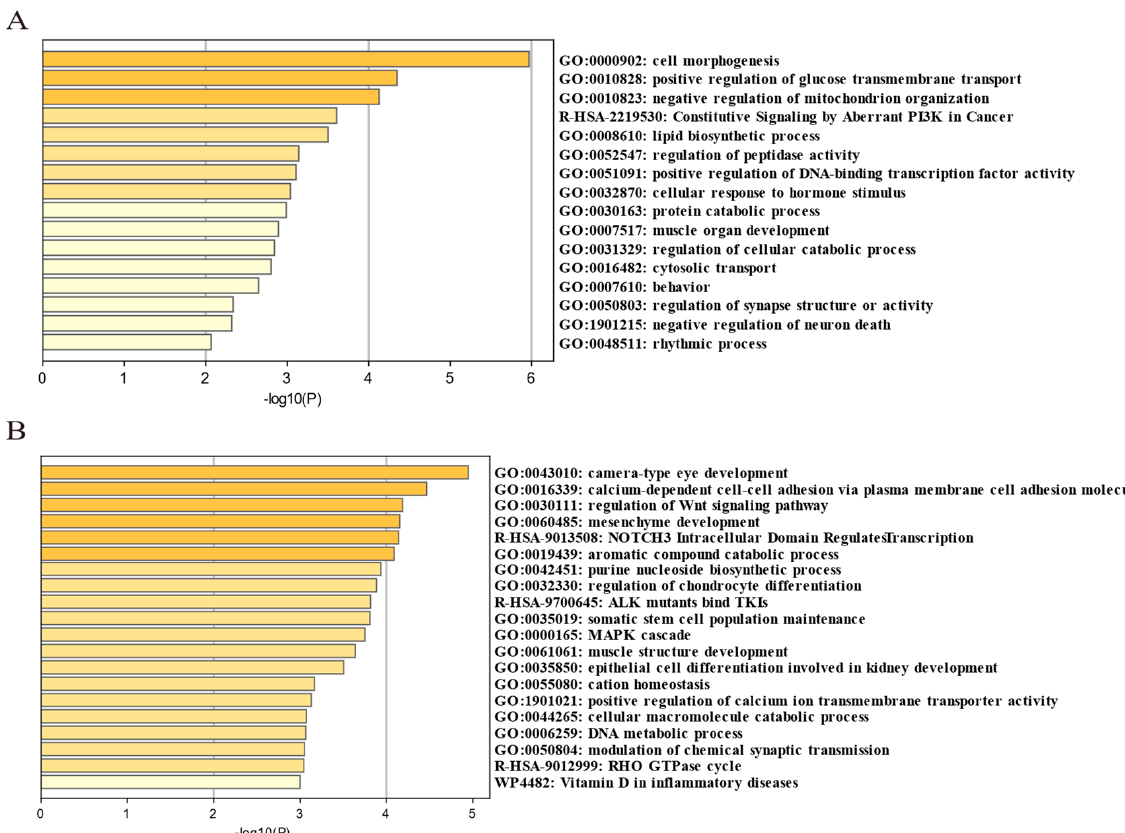
Figure 8. Enrichment analysis of common selected genes in gamecock chickens and those specific to HNG using Metascape. ( A ) Functional enrichment analysis of 52 common selected genes. ( B ) Functional enrichment analysis of 347 unique selected genes.